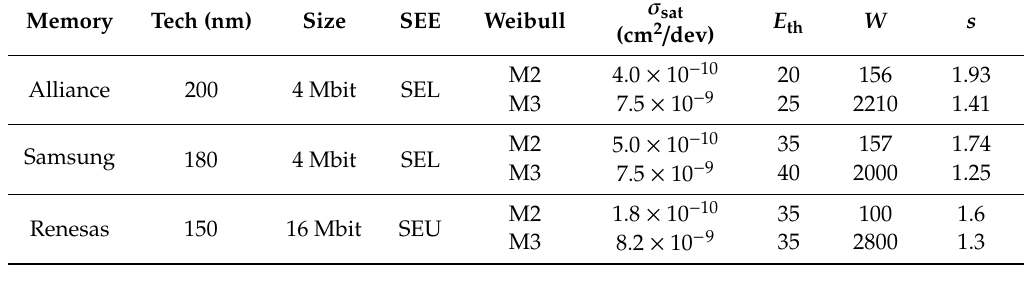
Table 2. Single event latch-up (SEL) and single event upset (SEU) static random access memory (SRAM) memories considered for the analysis—Weibull parameters.